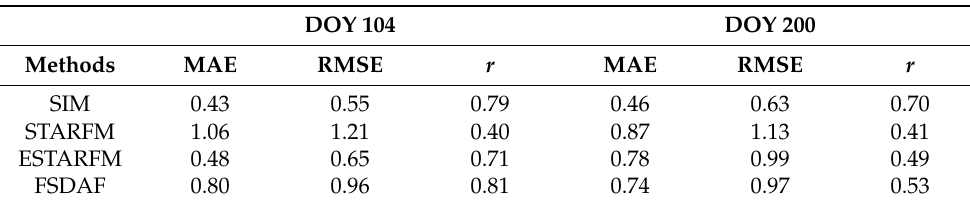
Table 11. Accuracies of different methods for LAI prediction at the CCN area from DOY 104 and DOY 200.